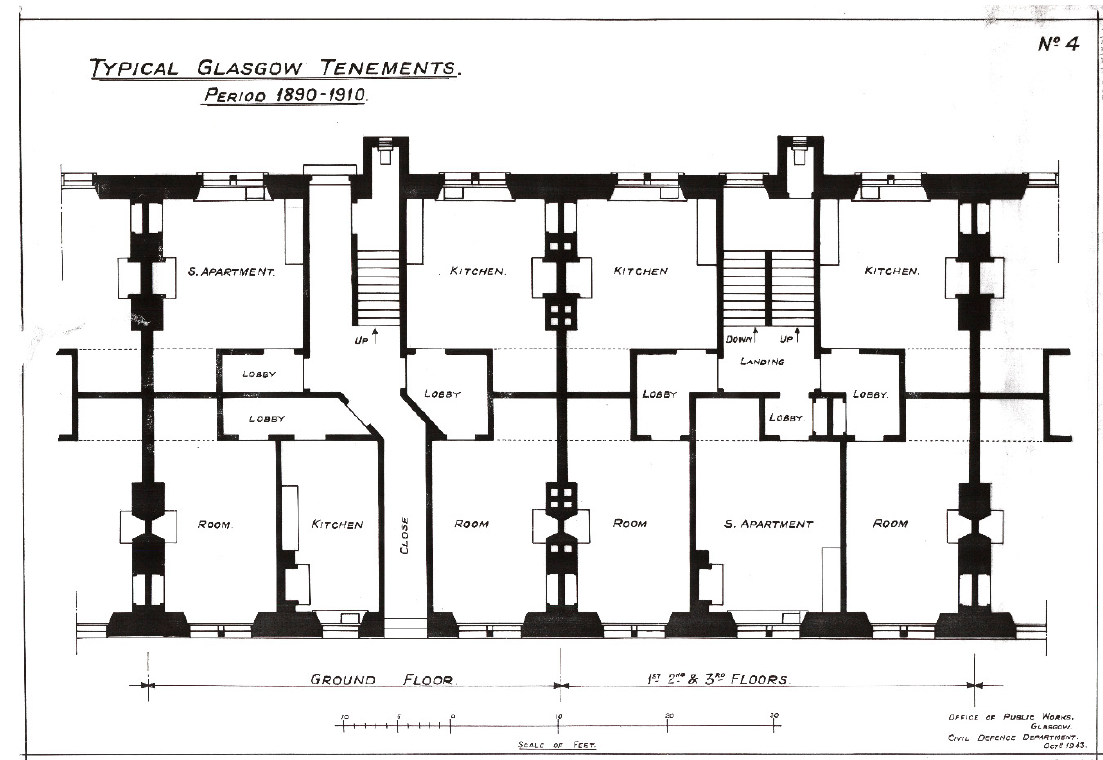
Figure 2. Typical Glasgow tenement plans. Reproduced with permission from Glasgow City Archives.